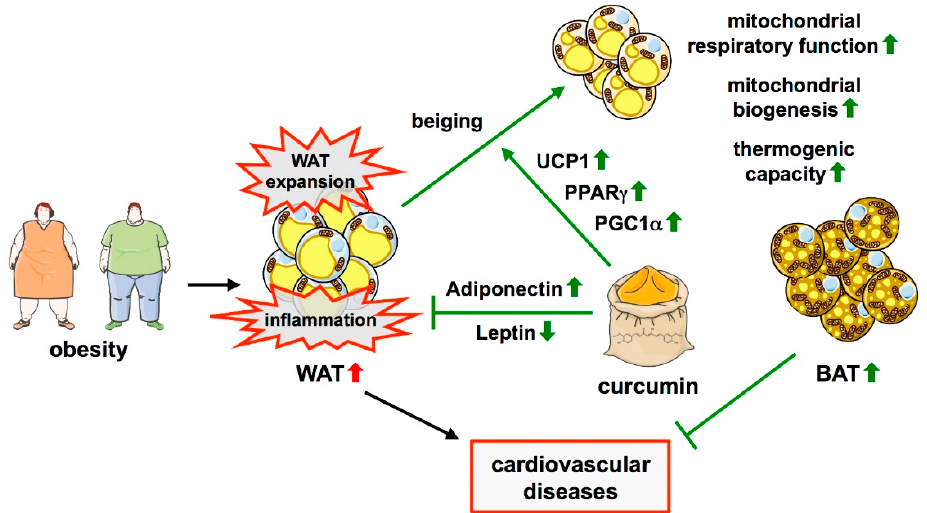
Figure 2. Protective effects of curcumin in obesity-induced adipose tissue dysfunction. Obesity is characterized by the expansion of WAT and inflammation therein. Curcumin can inhibit WAT expansion and obesity-induced adipose tissue inflammation. It is also linked to the process of beiging, the formation of beige adipocytes in WAT, which results in BAT-like characteristics of these cells. The underlying mechanisms include the upregulation of PPAR γ , PGC1 α , and UCP1, resulting in increased mitochondrial biogenesis, improved respiratory chain function, and thermogenesis. Moreover, curcumin induces an increase in Adiponectin levels with a concomitant decrease in Leptin, thereby reducing inflammation. ↑ —increased; ↓